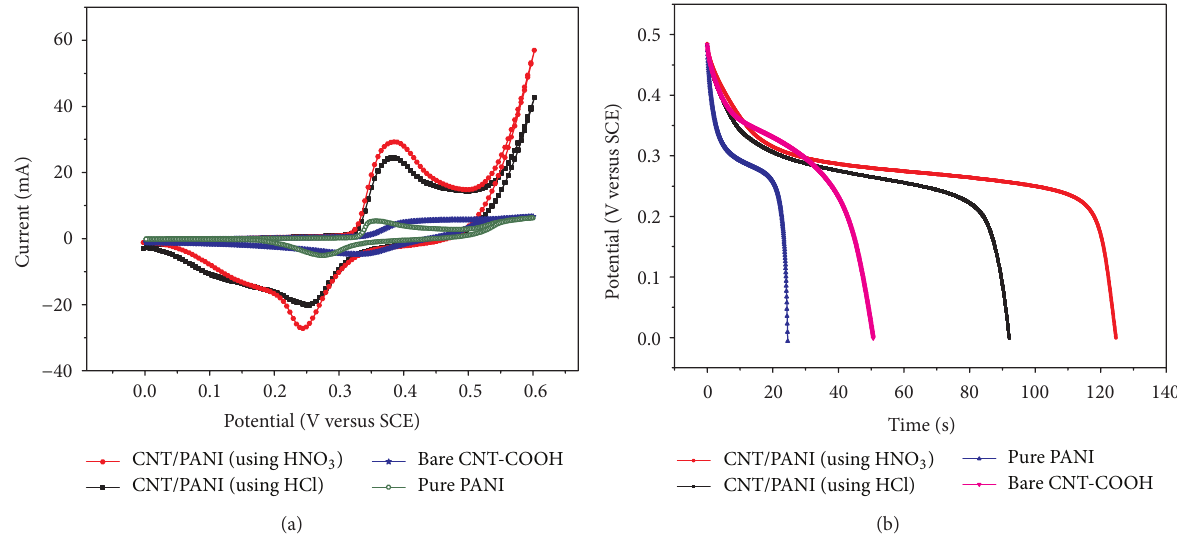
Figure 7: (a) CV curves of pure PANI, bare CNT-COOH, and CNT/PANI composites at scan rate of 10Vs −1 ; (b) galvanostatic discharge curves of pure PANI, bare CNT-COOH, and CNT/PANI composites at a current density of 2Ag −1